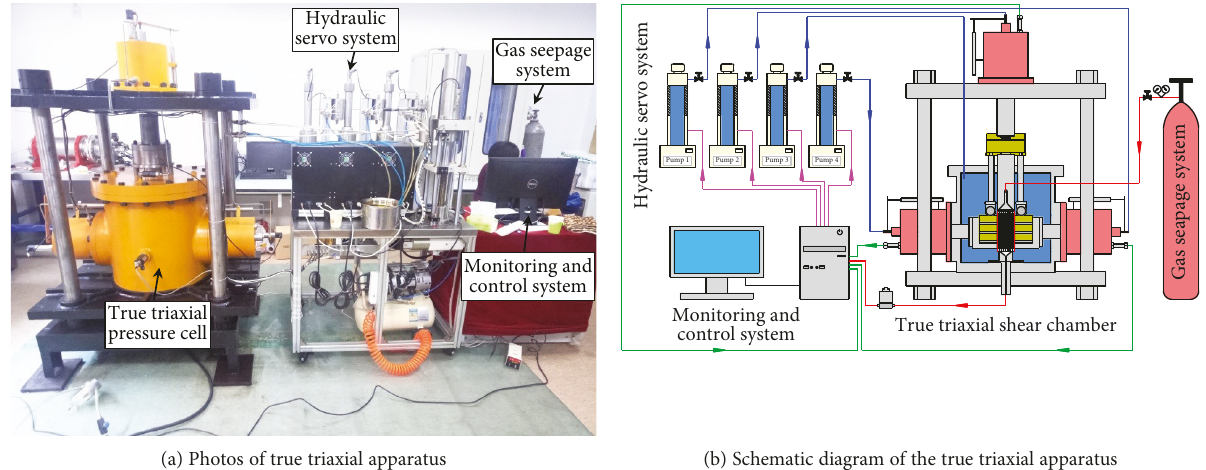
Figure 1: Diagrams of true triaxial